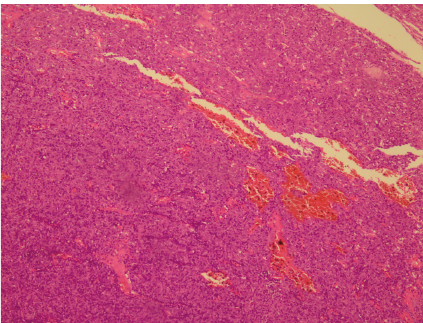
Figure 2: Microscopic view of first patient’s sample. Peritumoral fat shows a small microscopic focus of invasion (H&E stain × 40).